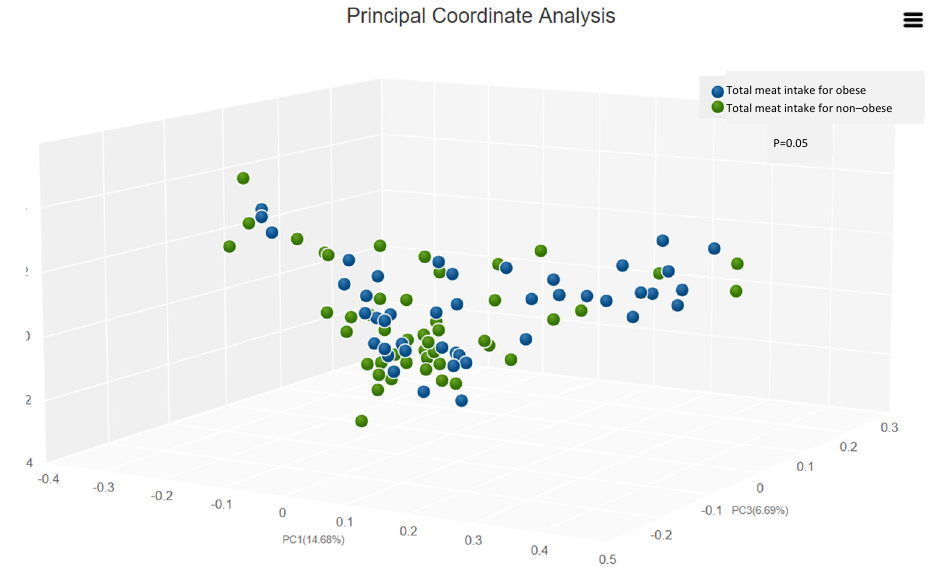
Figure 1. Total meat intake across obese and non-obese groups (beta diversity, Bray–Curtis).